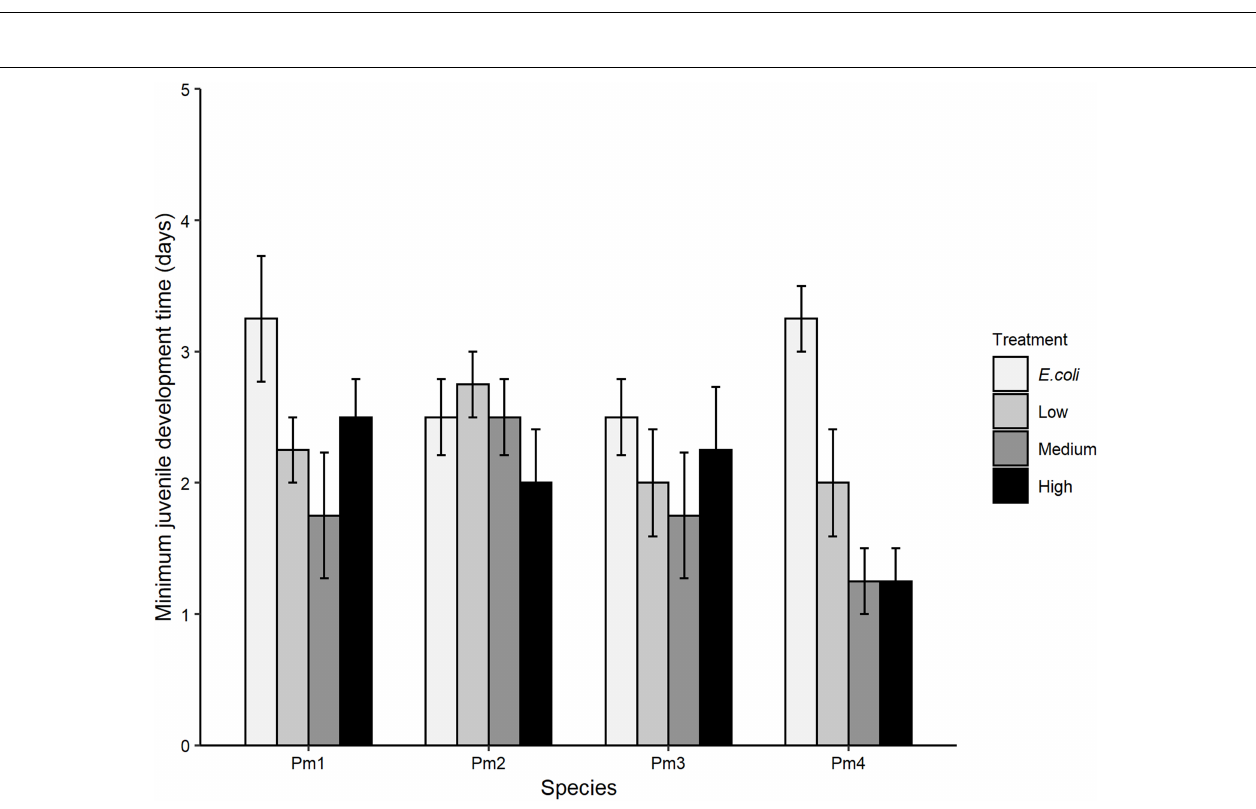
FIGURE 4 | Minimum juvenile development time (mean ± SE) for the four cryptic species of L. marina (Pm I, Pm II, Pm III, and Pm IV) in different food treatments ( E. coli , low diversity, medium diversity, and high diversity) ( n = 4).